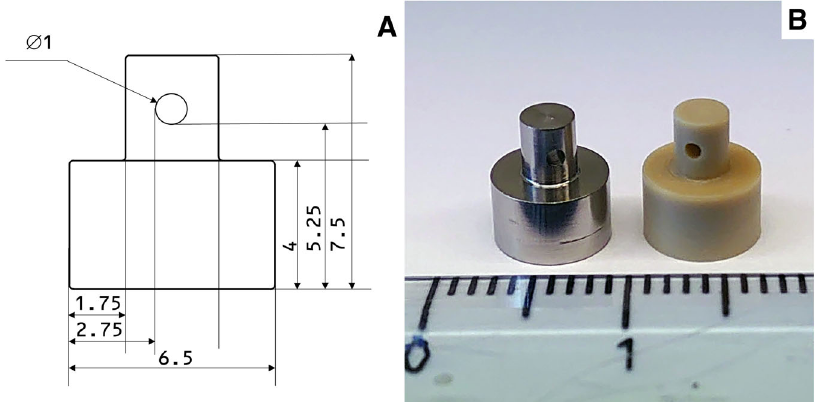
Fig. 1 A Drawing of the implant. Measurements in mm. B Photo of a Ti (left) and PEEK (right)